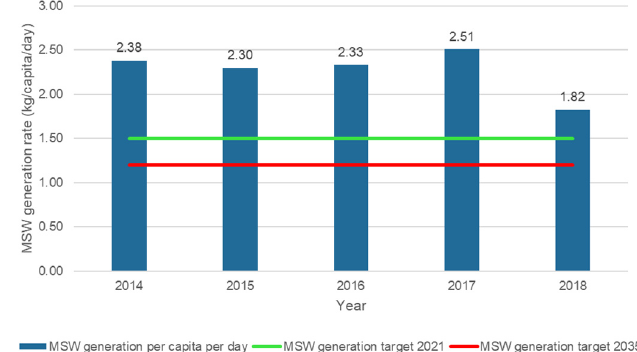
Fig. 7. recorded per capita waste generation with targets for